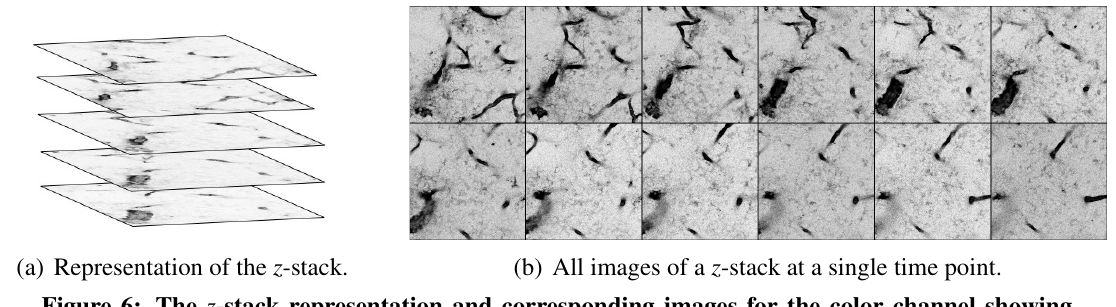
Figure 6: The z -stack representation and corresponding images for the color channel showing blood